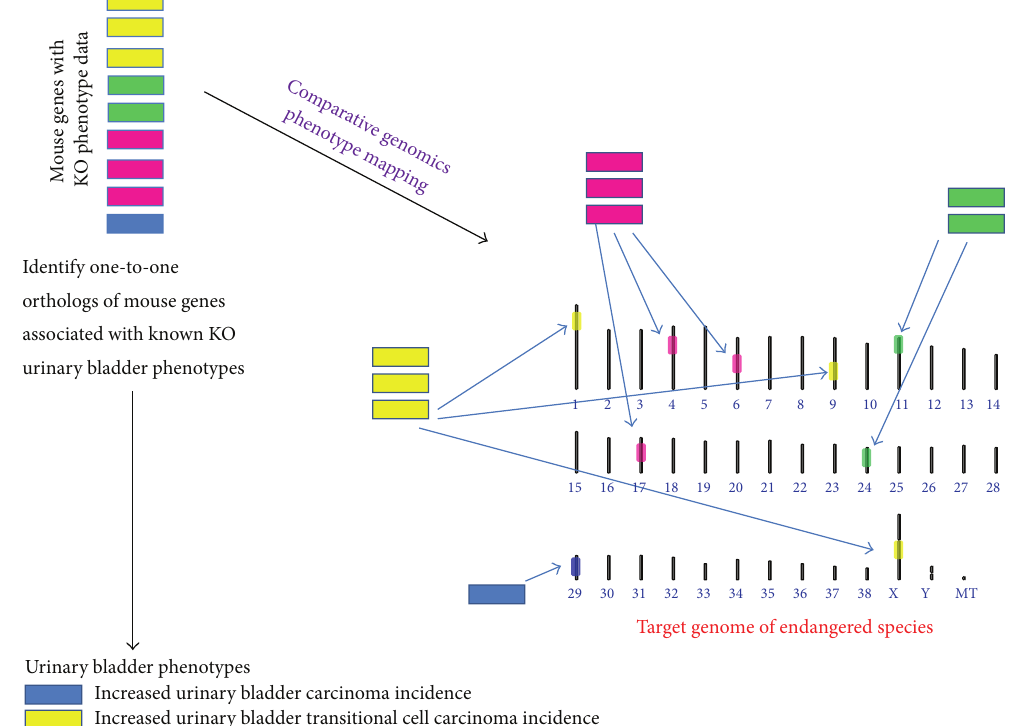
Figure 3: Comparative genomics approach to mapping phenotypes. Functional genomics information within a model organism genome, such as the mouse genome, can provide relevant and high confidence information about genes in other mammalian genomes. Nine mouse genes associated with phenotype data obtained from knockout (KO) strains of mice are represented in the top left corner of Figure 3. The resulting bladder cancer related phenotypes are indicated by the colors of the individual genes and the corresponding colors on the lower left corner of Figure 3. The mouse genes are mapped to their one-to-one orthologs in the target genome of an endangered mammalian species. The resulting locations of the orthologous genes are annotated with the same phenotype as the mouse gene. Blue: increased urinary bladder carcinoma incidence ; yellow: increased urinary bladder transitional carcinoma incidence ; pink: abnormal urinary bladder urothelium morphology ; and green: urinary bladder inflammation . Once the phenotypes are mapped to the target genome, SNPs most likely to disrupt the orthologs in the endangered species (nonsense mutations and frameshift mutations) provide potential genotype-phenotype associations that mirror the phenotypes observed in knockout